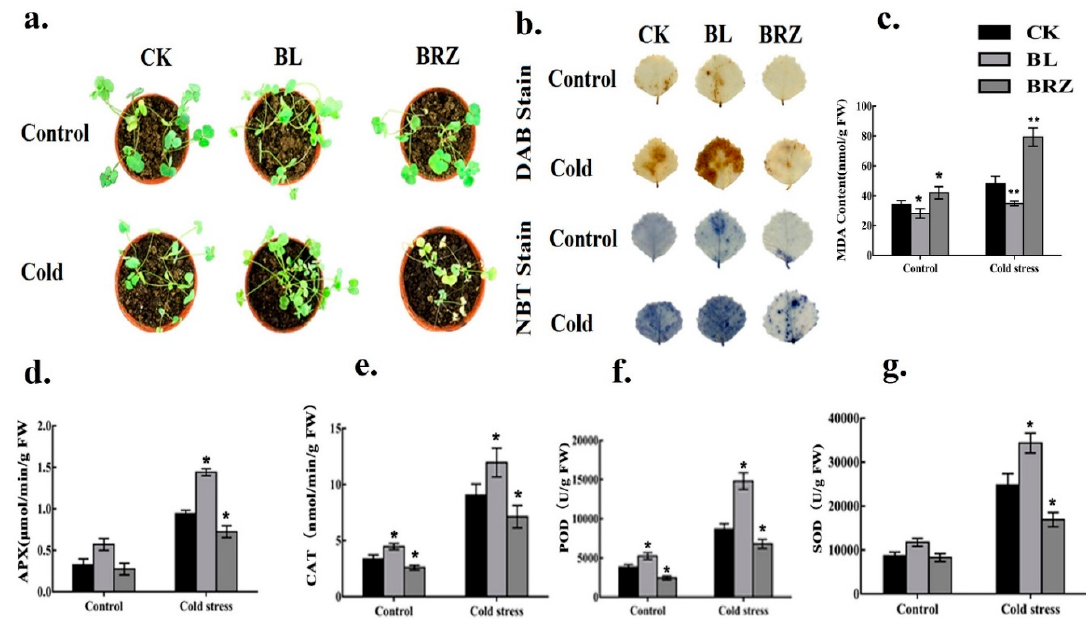
Figure 1. Effects of BRs treatment on cold stress tolerance in M. truncatula plants. Plants were pretreated with 1 µ M BL or 1 µ M BRZ or water (CK) to test BRs role. Both control (non-stressed) and cold